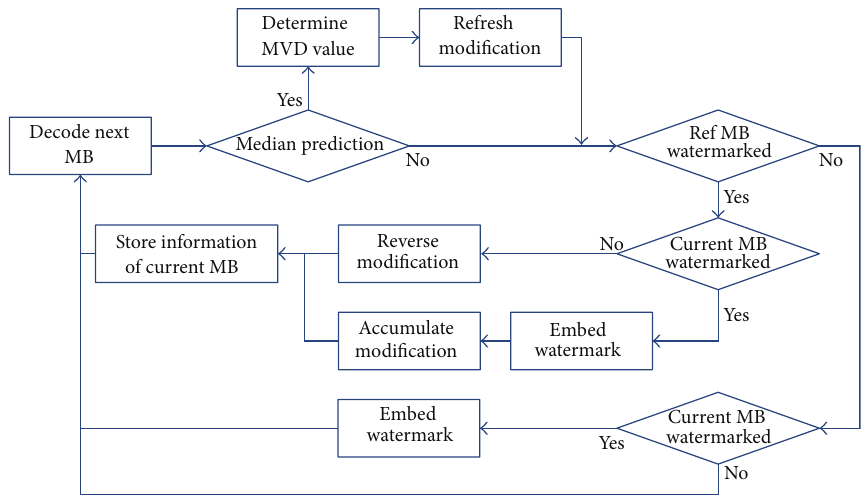
Figure 11: Drift compensation